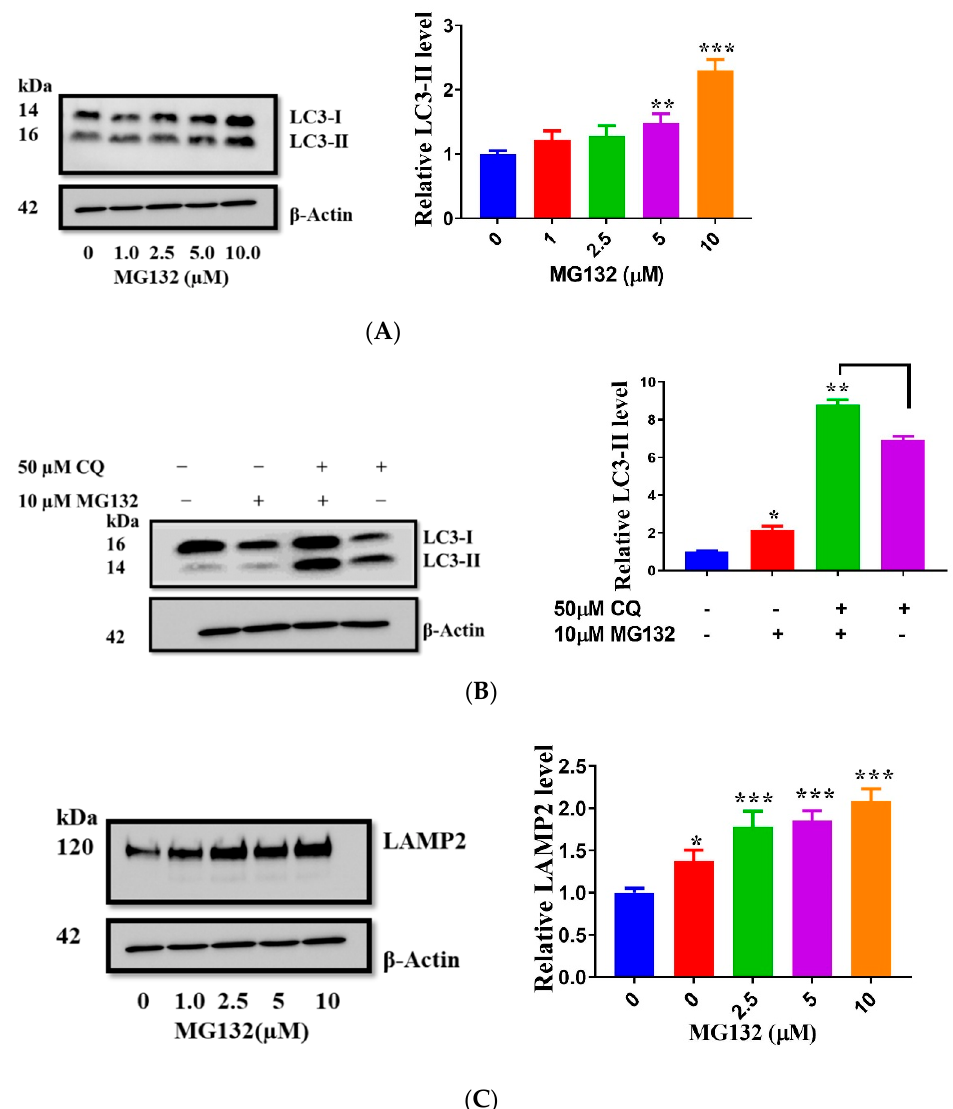
Figure 7. MG132 upregulates autophagy and LAMP2 expression in human RPE cells. ( A ) LC3-II levels increased in ARPE- 19 cells after treatment with MG132 for 5 h. ( B ) LC3-II levels in cells incubated with chloroquine for 8 h followed by incubating with MG132 for 5 h. ( C ) LAMP2 levels increased in cells after 5 h incubation with MG132. Protein levels were normalized with β -actin and expressed as a ratio of the control. Data represent the mean (+SD) of 3 independent experi- ments of 3 replicates each. Statistical analysis using one-way ANOVA followed by Dunnett’s or Sidak’s multiple compari- sons test. * p < 0.05, ** p < 0.01, *** p < 0.001, significant difference relative to the